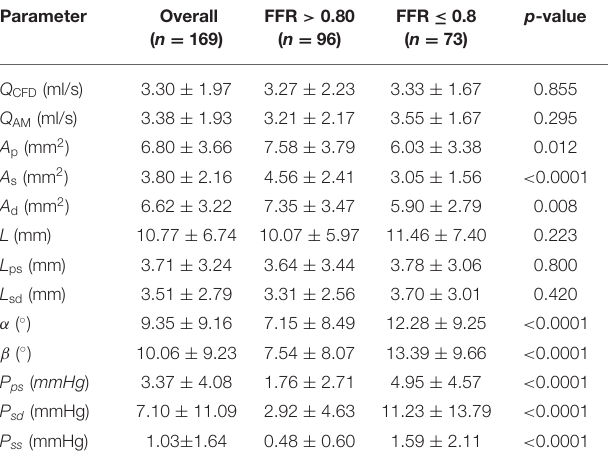
TABLE 1 | Patient characteristics. TABLE 2 | Characteristics of flow rate, anatomical parameters, and pressure drop over various coronary lesion segments to calculate the non-invasive FFR AM overall and by study group (ischemic group: FFR ≤ 0.8; non-ischemic group: FFR >